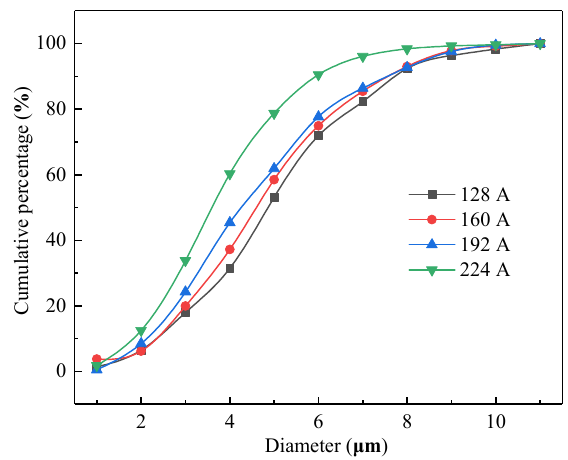
Figure 7. Cumulative percentage of grain size at different currents.